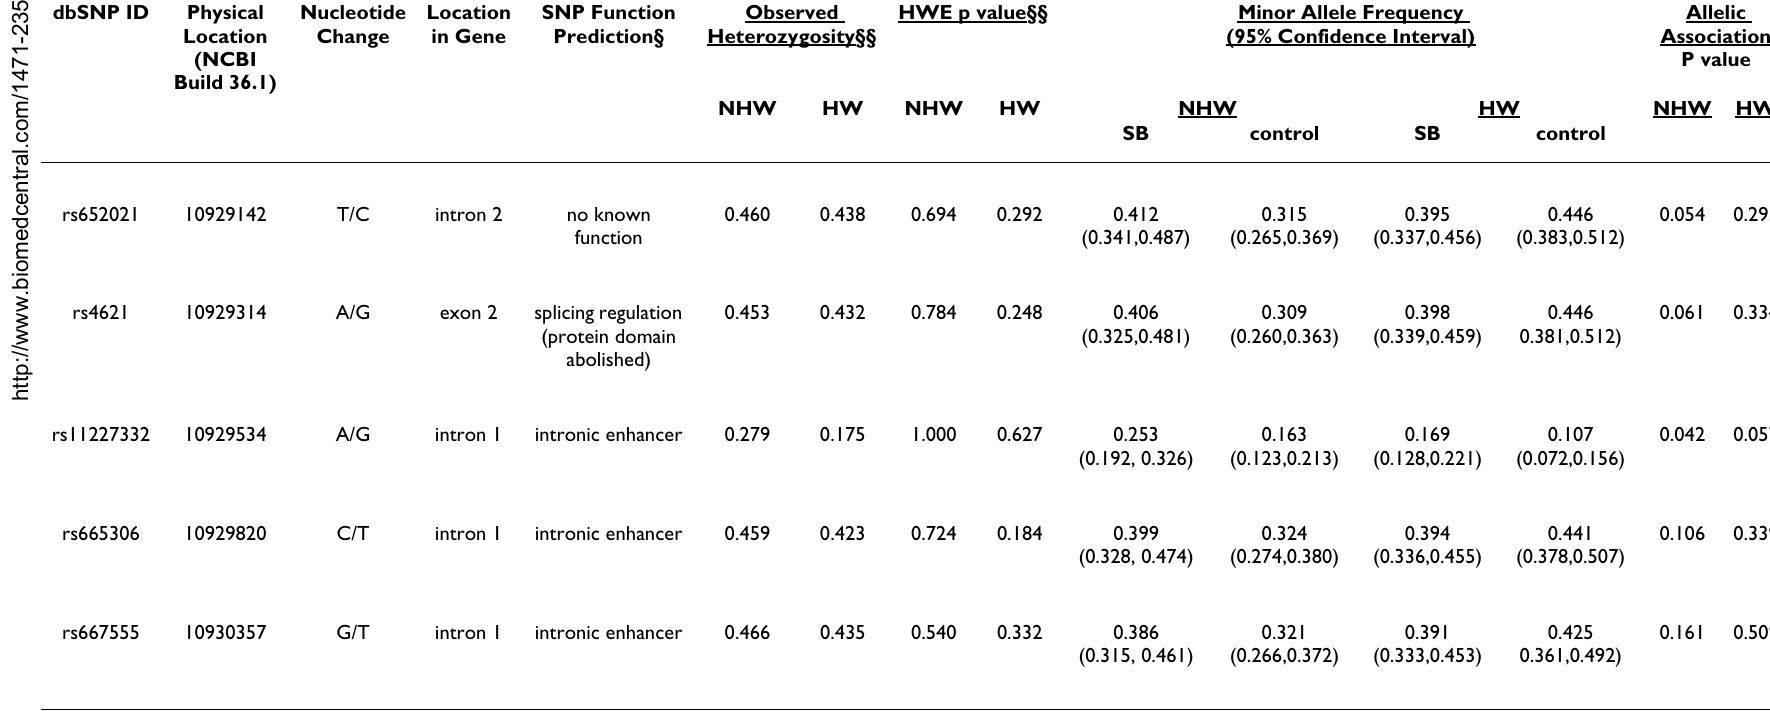
Table 2: Characteristics of CFL1 SNP markers and allelic association analysis for spina bifida, non-Hispanic White vs . Hispanic